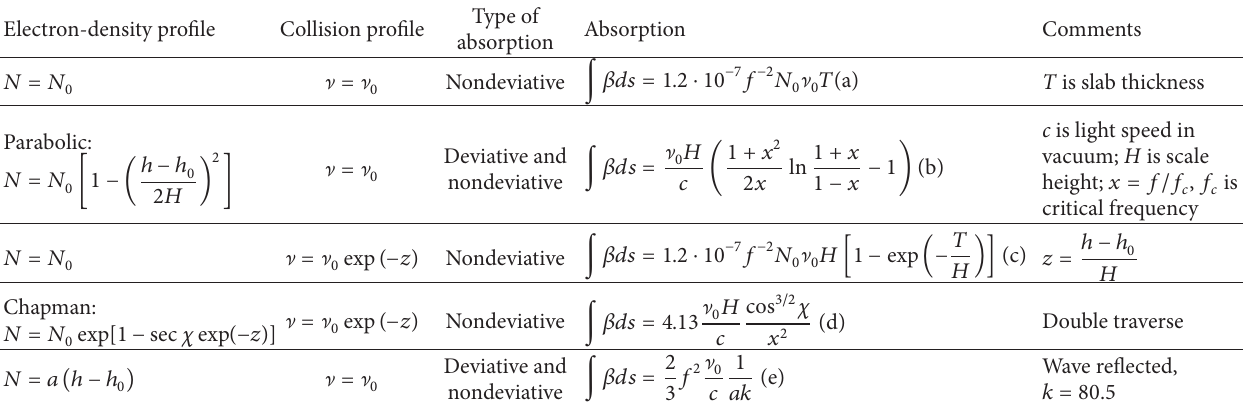
Table 1: Total absorption in model layers (reproduced from Davies